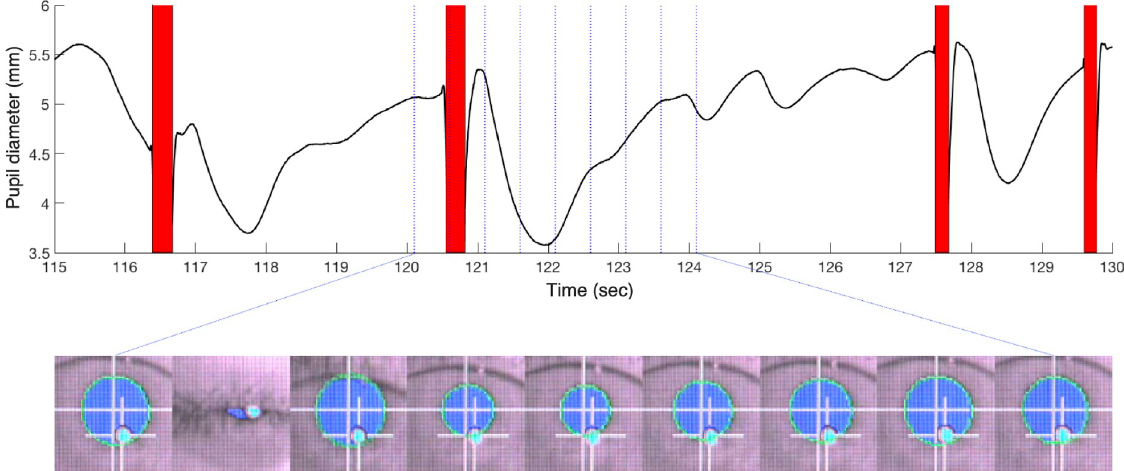
Fig 1. Example of blink-locked pupillary response (BPR). Raw pupil diameter time course example (top panel), and snapshots of recorded eye video (bottom panel). At the top panel, red bars indicate blinks, and blue vertical lines indicate the time of each eye image snapshot. At the bottom panel, the blue circle is a pupil area defined by the eye tracker, and the cyan circle is a corneal reflection. The snapshots are 4-s long and 2Hz frame rate. It clearly shows blink-locked pupillary response (BPR), that pupil constricts and re-dilates transiently after blinking. See the video (S1 Video) for vivid BPR